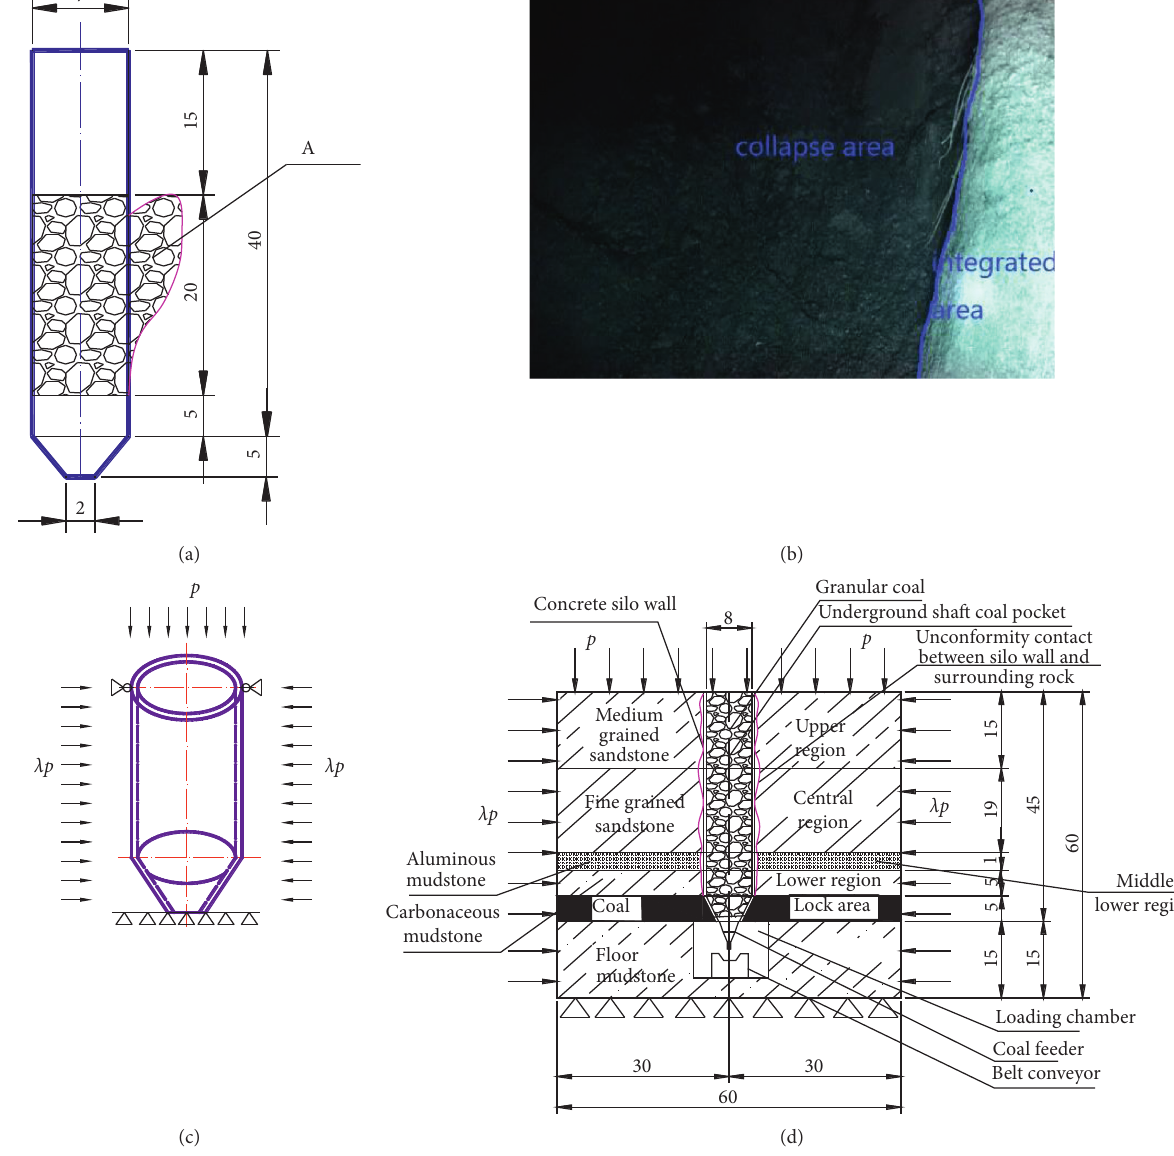
Figure 1: Simplified mechanical model of concrete shaft wall and surrounding rocks. (a) Damage site of the silo wall where “A” is the collapse area. (b) Comparison of the collapse area and integrated area [9]. (c) Simplified mechanics model of the silo wall. (d) Simplified mechanics model of the silo wall and surrounding